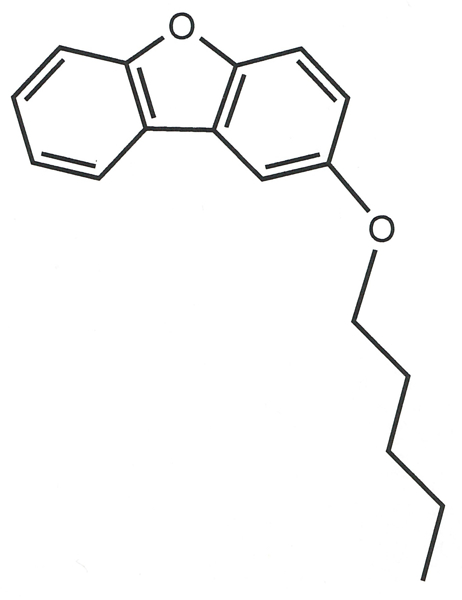
Chemical scheme